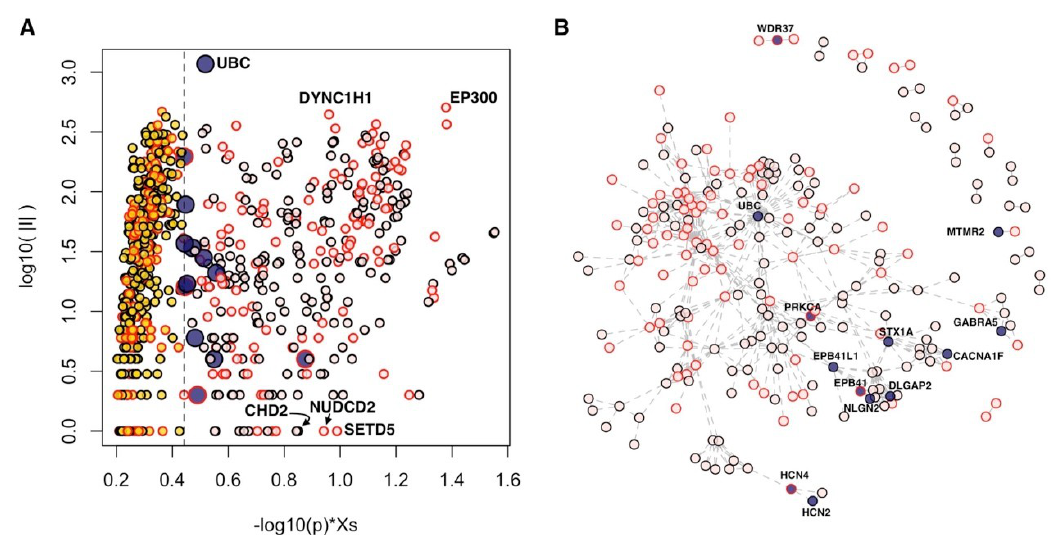
Figure 1. Genes in network proximity to the core genes of autism spectrum disorders (ASDs). ( A ) Diffusion score (Xs) normalized by its empirical p-value (horizontal axis) and number of interactions (|I|, vertical axis); only genes with p < 0.05 are shown. ( B ) Connected components of “core+13” network. ( A , B ) Blue points: 13 genes of “core+13”; pink points: core genes; yellow points: Significant genes outside “core+13” genes; red border of points: Genes supported at transcriptomic and/or epigenetic levels.